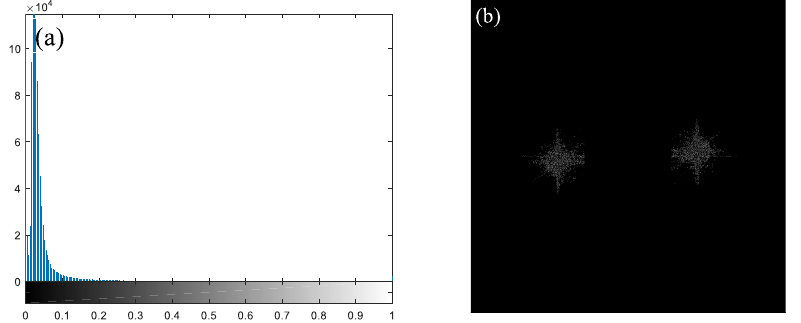
Figure 5. ( a ) Gray histogram of the high-frequency component; ( b ) binary image of the high-frequency component.